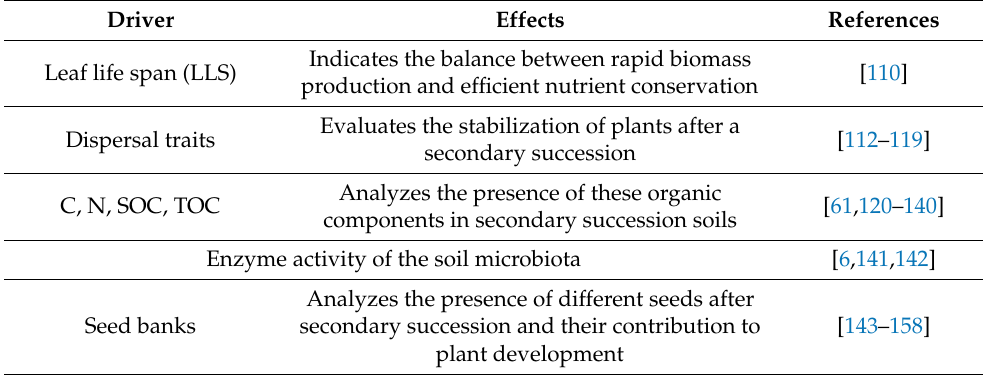
Table 2. Important drivers in a secondary succession. Driver